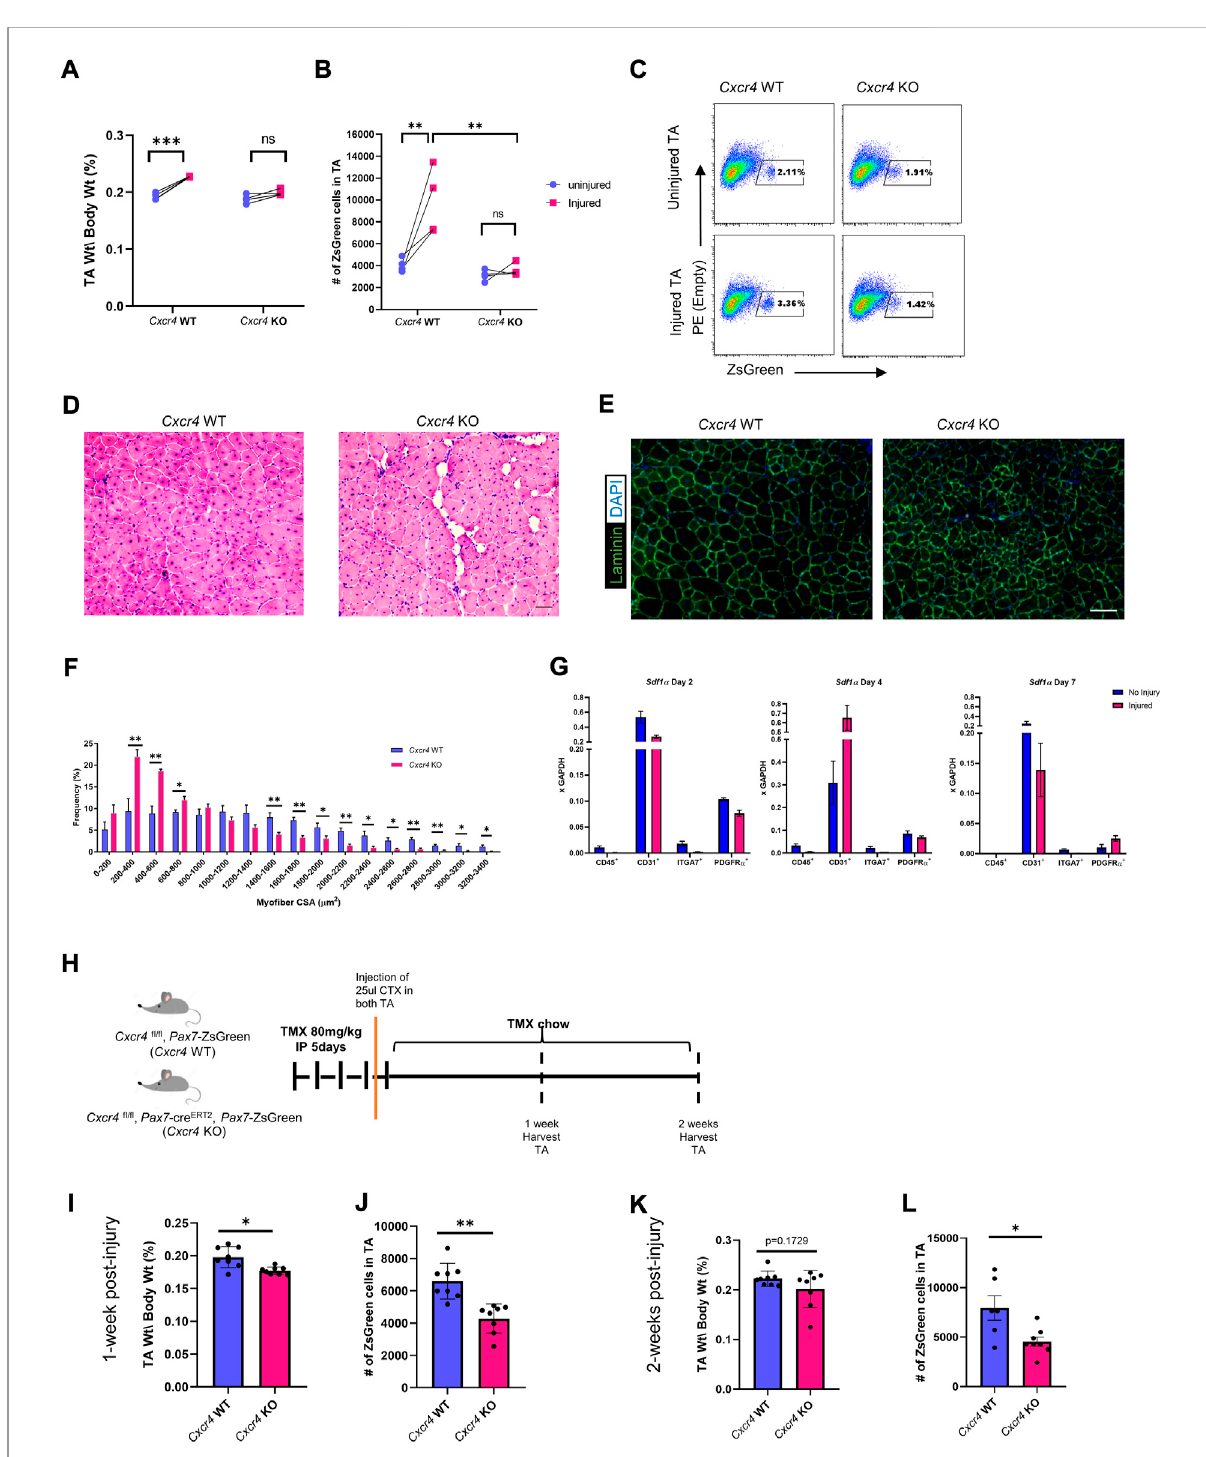
FIGURE 2 CXCR4 is necessary for proper skeletal muscle regeneration andexpansionof thesatellite cell poolafter injury. (A) TAmass normalizedto body weightinuninjuredandinjured, Cxcr4 WTandKO,mice. (B) TotalnumberofZsGreen + cellsintheTAmuscleofuninjuredandinjured, Cxcr4 WT( n = 4) and KO ( n =4), mice. (C) Representative FACSplots showing thetotalnumber ofZsGreen + cells inuninjuredand injured, Cxcr4 WT ( n = 4) and KO ( n =4),mice. (D) RepresentativeH&EstainingofTAsectionsfrom Cxcr4 WTandKOmice4 weeksafterthesecondinjury.Scalebar=50 µm. (E) Representative IF stainingfor laminin(green) and DAPI(blue)in TAsectionsfrom Cxcr4 WT and KOmice 4 weeks after thesecond injury. Scalebar = 100 µm. (F) Myo fi ber cross sectional area distribution in TA muscles of Cxcr4 WT ( n = 5) and KO ( n = 5), 4 weeks after the second injury. (G) RTqPCR